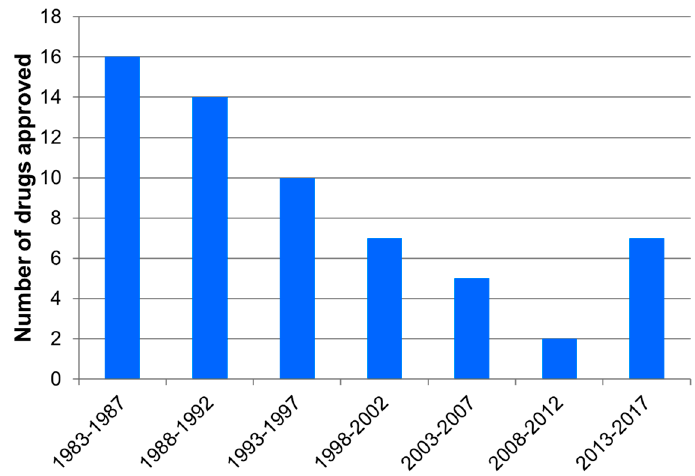
Figure 2. Evolution of the FDA-approved antibiotics since 1983. Modified from Reference [10] and completed with References [11,12].